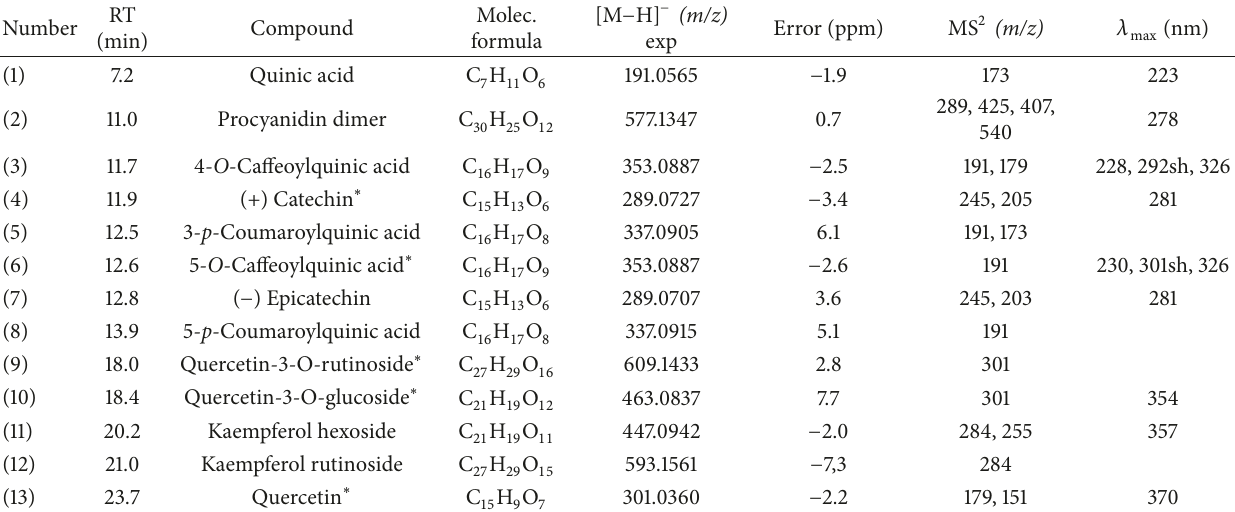
Table 1: Polyphenols identified in quince